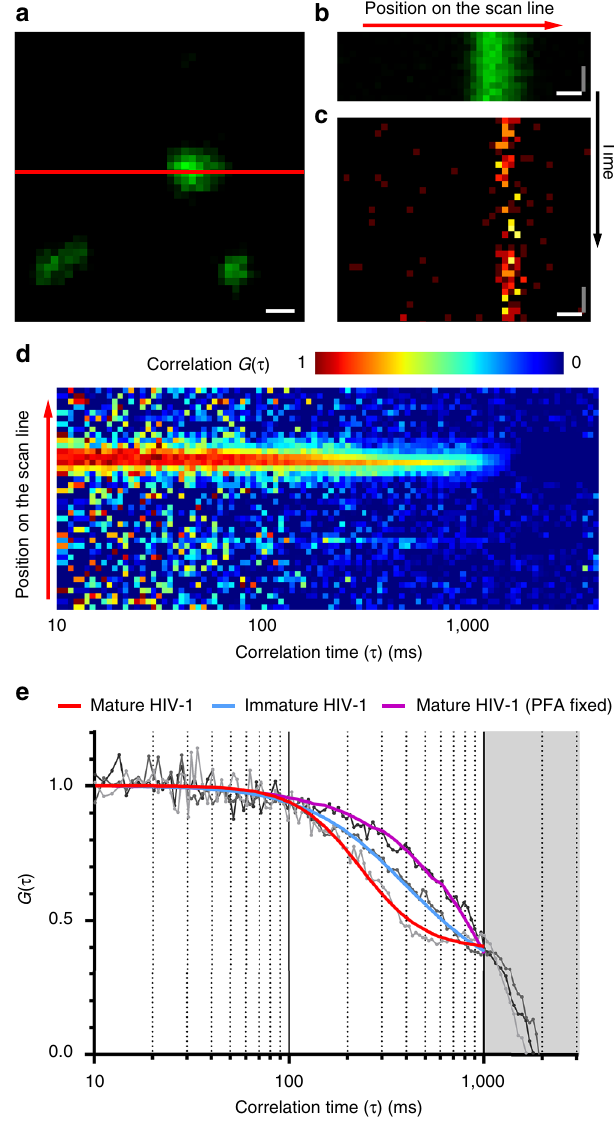
Fig. 2 sSTED-FCS measurements of Env diffusion on HIV-1 particles. a Live confocal imaging was used to locate HIV-1 virus particles in a 2 µ m × 2 µ m imaging window using the eGFP.Vpr signal ( green ) as a guide and to align them with the position of the scan line ( red ). Scale bar: 200 nm. b , c Representative signal intensity carpets for eGFP.Vpr ( green ) in confocal mode and Env ( orange ) in STED mode on wild-type mature HIV-1 particles. Image x - and y -axis correspond to the position on the scan line and signal intensity at each time point, respectively. Scale bars: x -axis ( white ) = 200 nm, y -axis ( grey ) = 4.4ms. d Correlation carpet generated from signal intensity carpet shown in c . Image x - and y -axis correspond to correlation time τ and the position on the scan line, respectively. Colour code corresponds to the normalised autocorrelation curves G ( τ ) at each position on the scan line. e Representative normalised autocorrelation curves of Env diffusion ( grey and black lines) obtained from individual positions on the scan line within correlation carpets. Autocorrelation curves were fi tted ( coloured lines ) for mature ( red ), immature ( blue ) and PFA fi xed HIV-1 particles ( purple ) using generic two-dimensional diffusion model. Greyed out area corresponds to the photobleaching-only portion of the correlation